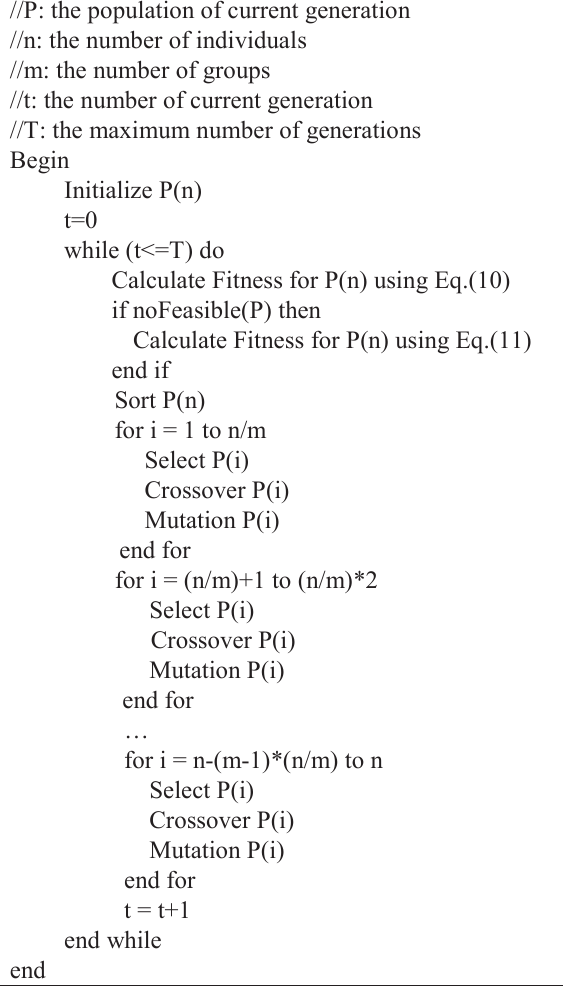
Table 2 Process of MGA